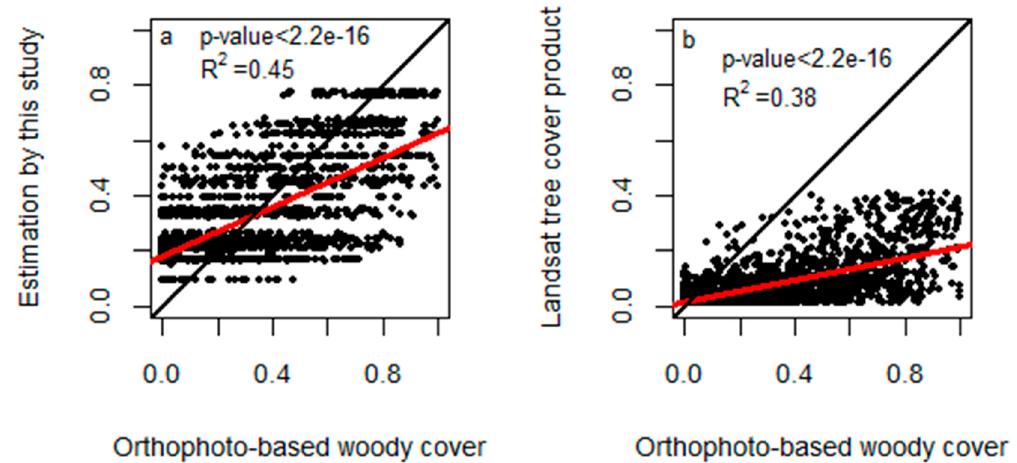
Figure 6. Per-pixel validation of estimated fractional woody cover by this study ( a ) and 2012 Landsat VCF tree cover product ( b ).